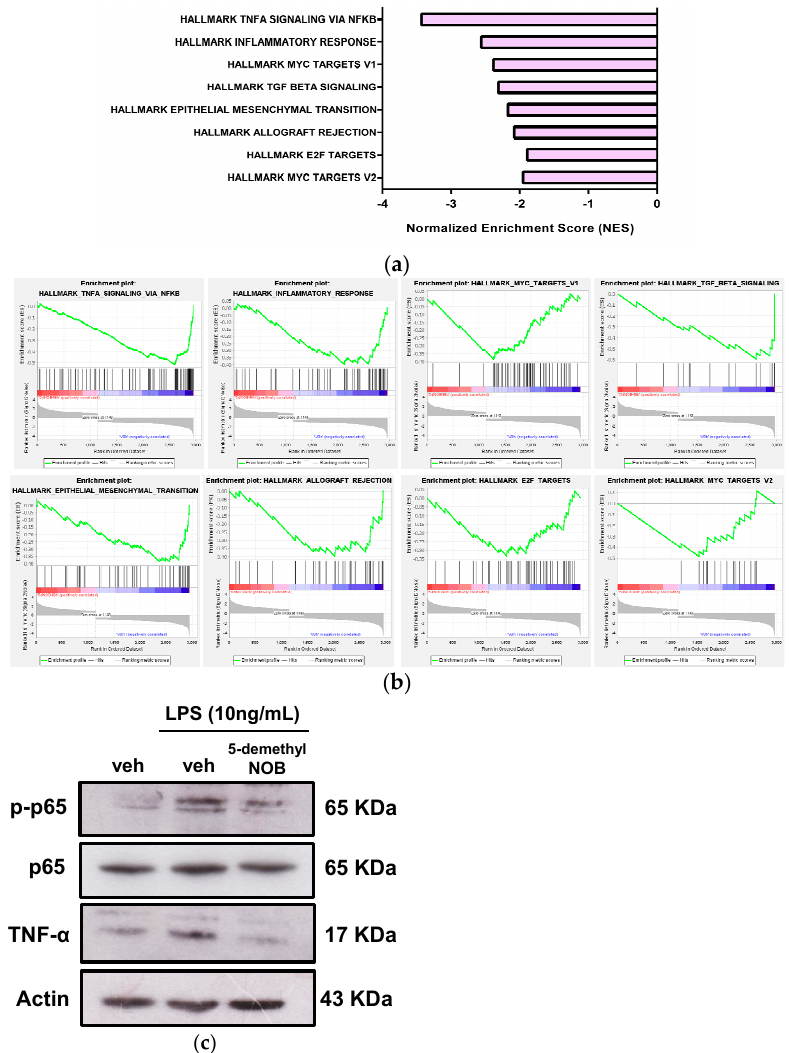
Figure 7. The hallmark gene sets of molecular pathways in response to 5-demethyl NOB treatment. ( a ) The top eight hallmark gene sets of molecular pathways associated with genes downregulated by 5-demethyl NOB. ( b ) GSEA demonstrates that the signature “Hallmark” gene set is enriched in the DEGs by 5-demethyl NOB treatment. ( c ) THP-1 cells were pretreated for 1 h with vehicle or 5-demethyl NOB and then incubated with LPS (10 ng/mL) for 24 h. p-p65, p65, TNF- α and actin proteins were detected by Western blot analysis. A representative blot is shown. 2.7. Effects of Combined Treatment with 5-Demethyl NOB and Cytarabine in AML Cells Cytarabine (Ara-C) is a key therapeutic agent for the standard treatment of AML. We further examined the antileukemic effects of combined 5-demethyl NOB and Ara-C on AML cell lines. THP-1 cells were incubated with Ara-C (10 μ M), 5-demethyl NOB (20 and 40 μ M) or both compounds, and cell viability was analyzed using the MTT assay. As shown in Figure 8a, cells were treated with Ara-C (0–20 μ M) for 48 h, and cell viabil- ity was reduced from 100.0 ± 4.2% to 54.3 ± 7.1% in a dose-dependent manner. These data were consistent with our previous report [15]. As shown in Figure 8b, in the Ara-C (10 μ M) and 5-demethyl NOB (20 or 40 μ M) cotreated groups, a significant reduction in cell viability was noted compared with Ara-C- or 5-demethyl NOB-treated cells ( p < 0.01). This data indicated that a combination of cytarabine and 5-demethyl NOB demonstrated an enhanced cytotoxic effect for the alleviation of the cell viability compared with cytar- abine- or 5-demethyl NOB-alone treated cells. The combination index (CI) values calcu- lated in the combination of Ara-C (10 μ M) with 5-demethyl NOB (20 and 40 μ M) were 0.72 and 0.91 (CI < 1), respectively. These results demonstrated a synergistic effect of the combination of Ara-C with 5-demethyl NOB treatment in THP-1 cells. A similar syner- gistic effect of Ara-C (0.125 μ M) and 5-demethyl NOB (20 and 40 μ M) cotreatment on the reduction of cell viability was also found in U-937 cells (Figure 8c,d). The data demonstrated the therapeutic potential of 5-demethyl NOB supplemented with Ara-C in AML treatment. Our findings suggested that low and nontoxic concentration of 5-demethyl NOB combined with reduced doses of cytarabine treatment resulted in more inhibitory effects on leukemia cell growth.